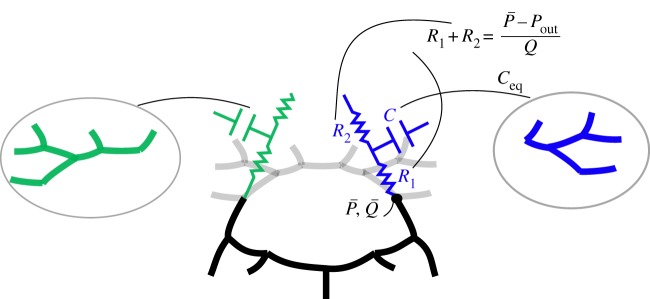
Illustration of vessels distal of points of truncation lumped into WK3 models.